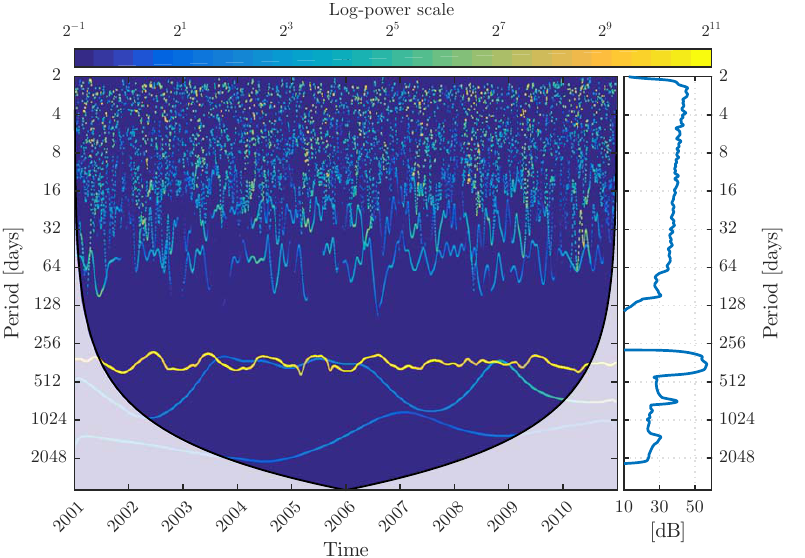
Figure 3. The Hilbert spectrum (left panel) of the ten year time-series of SSI under study, spanning 2001 through 2010. Pixel colour encodes power (logarithmic scale colour bar on top) at each time (abscissa) and each scale (ordinate). Time markers on the abscissa denote the start of the corresponding year. The white-out area indicates the regions where edge effects become significant. The Hilbert marginal spectrum in the right panel is the time-integrated version, i.e. line-by-line sum, of the Hilbert spectrum and indicates the amount of power at each scale, expressed in dB.